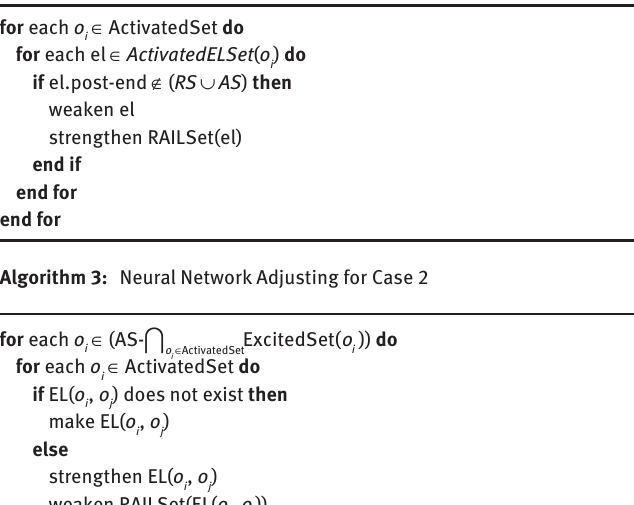
Algorithm 2: Neural Network Adjusting for Case 1